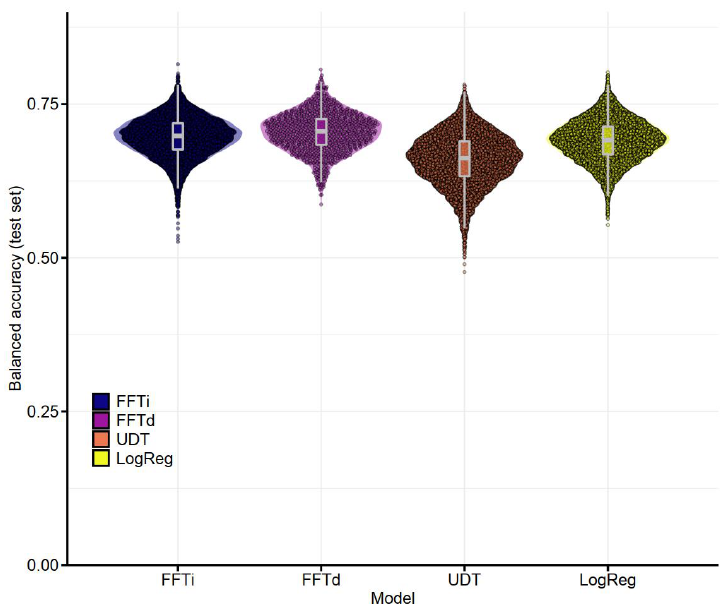
Figure 3. Balanced accuracy in the test set (prediction task) for the four algorithms across trials with all cues : The graph shows boxplots and violin plots, with dots representing the results of individual trials (10,000 trials for FFTi, UDT and LogReg; 1000 trials for FFTd). FFTi—fast-and-frugal tree construction using the ifan algorithm, FFTd—fast-and-frugal tree construction using the dfan algorithm, UDT—unconstrained decision tree based on the CART algorithm, LogReg—logistic